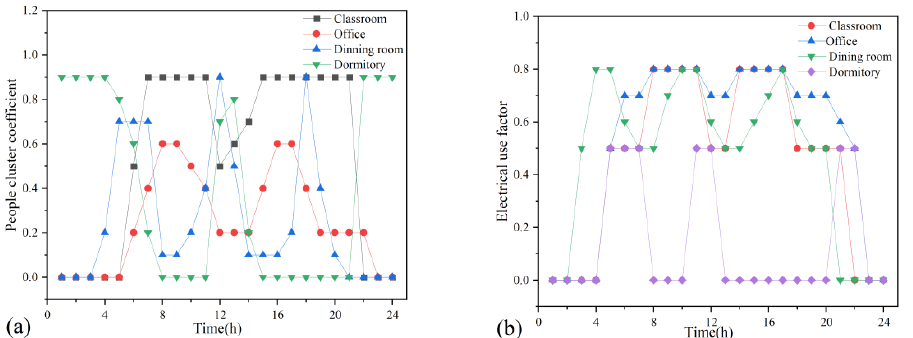
Figure 6. Hourly utilization coefficient ( a ) for people, ( b ) for electrical equipment.